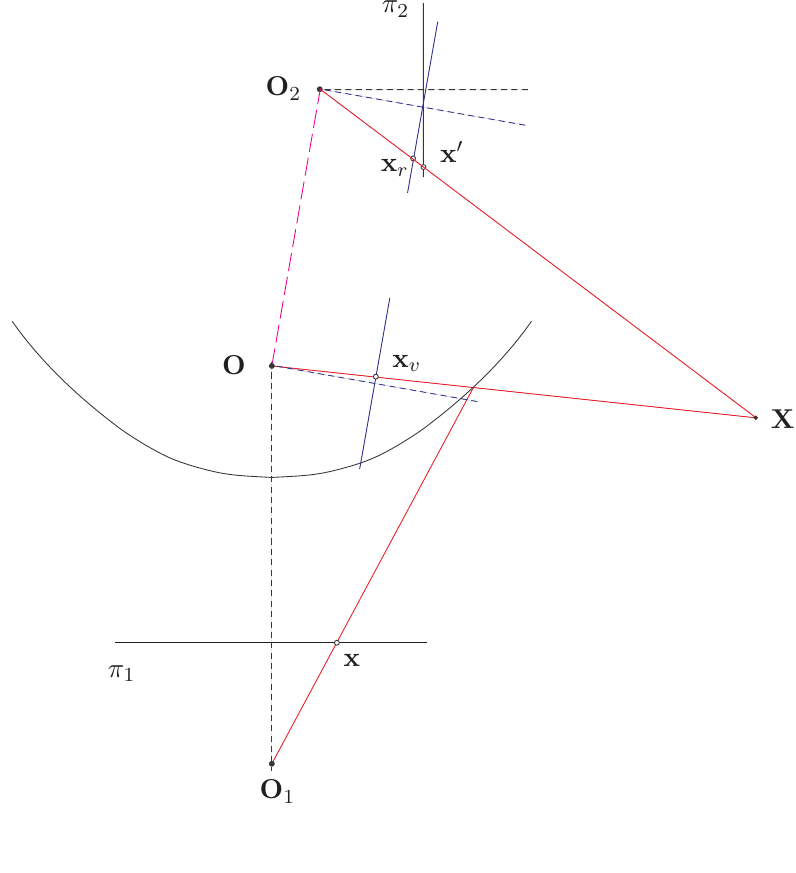
Figure 2. The proposed HOPIS configuration. O the catadioptric and perspective cameras, respectively. O is the effective viewpoint of the catadioptric image formation. A 3D scene point X is projected to x and x ′ on the omnidirectional and perspective images,